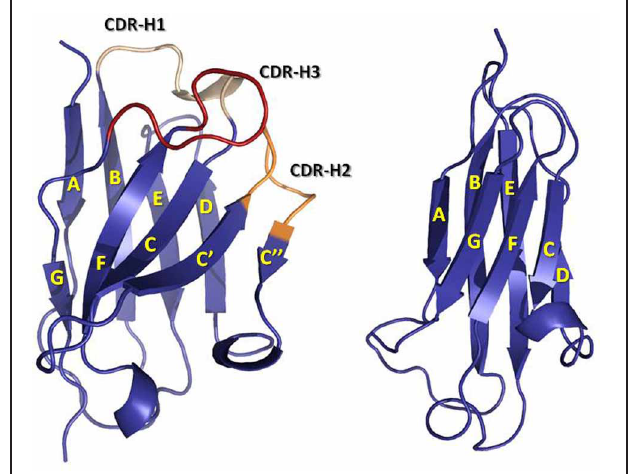
FIGURE 2 | Ribbon representation of a V H (left) domain and a C H 1 (right) domain. CDRs are colored in yellow (CDR-1), orange (CDR-2), and red (CDR-3). Note the insertion in the V H domain with respect to the C H 1 domain of two β -strands, C’ and C”, and the loop linking them, which contains the CDR-H2. The coordinates used to produce the Figure were the same as in Figure 1 . The figure was generated with